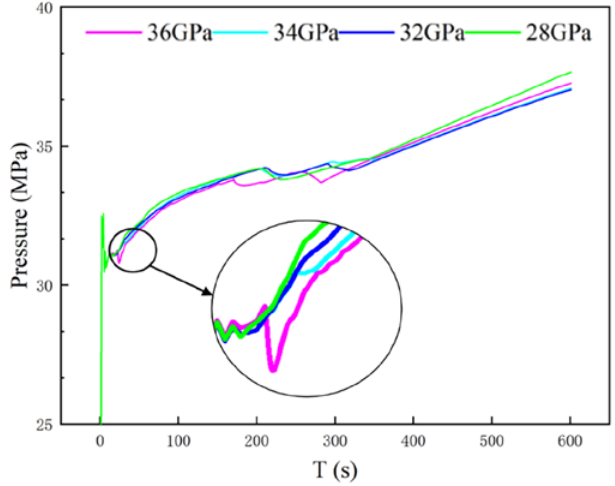
Figure 9. Pore pressure at injection point with different Young’s modulus. Table 2. The rock mechanics parameters of the stratum.